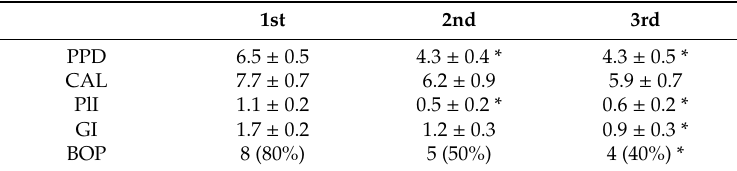
Table 4. Changes in clinical parameters at diseased sites.